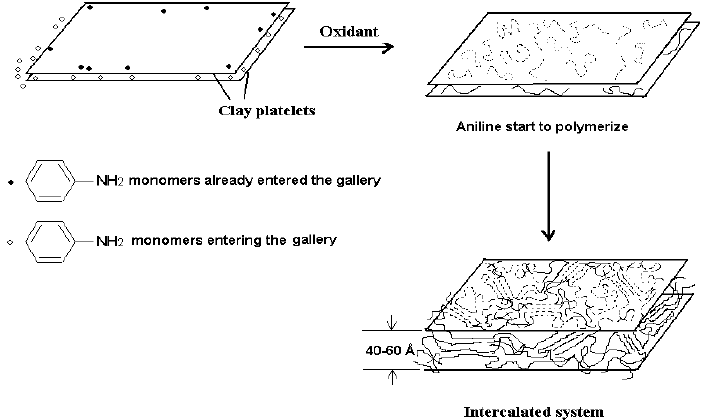
Figure 11. Schematic representation of in situ polymerization of